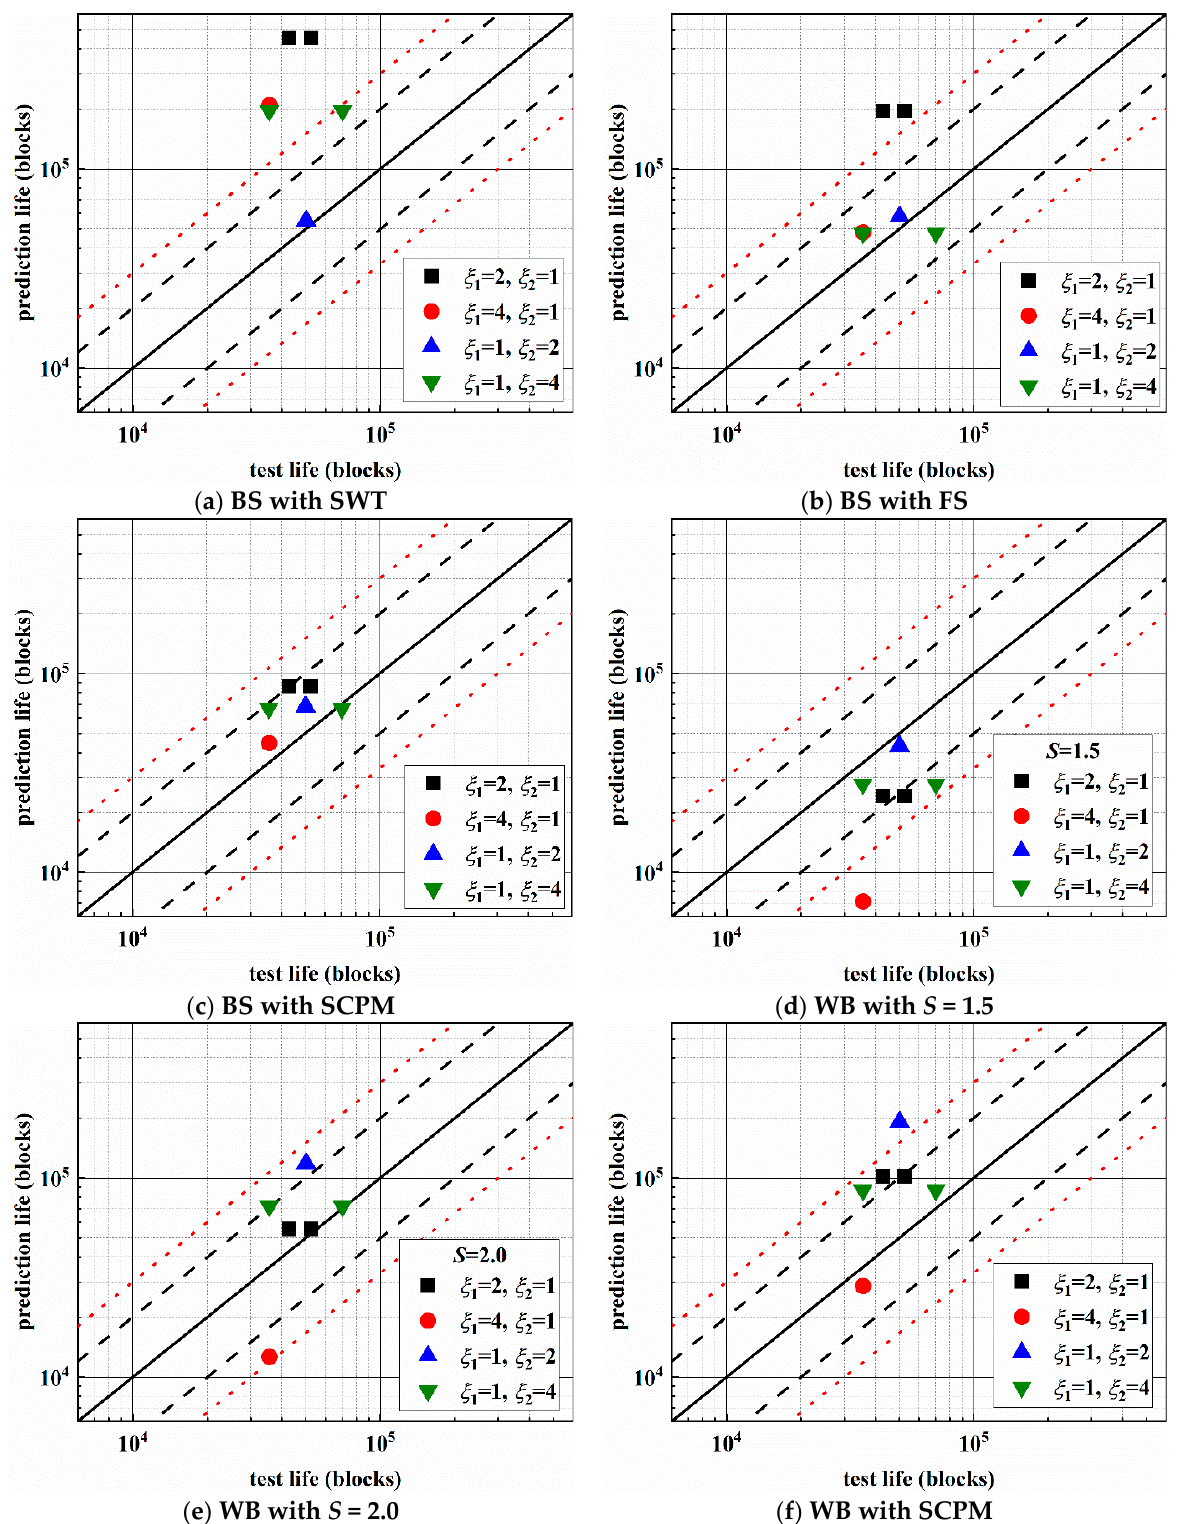
Figure 15. Prediction life vs. test life under different frequency ratios.